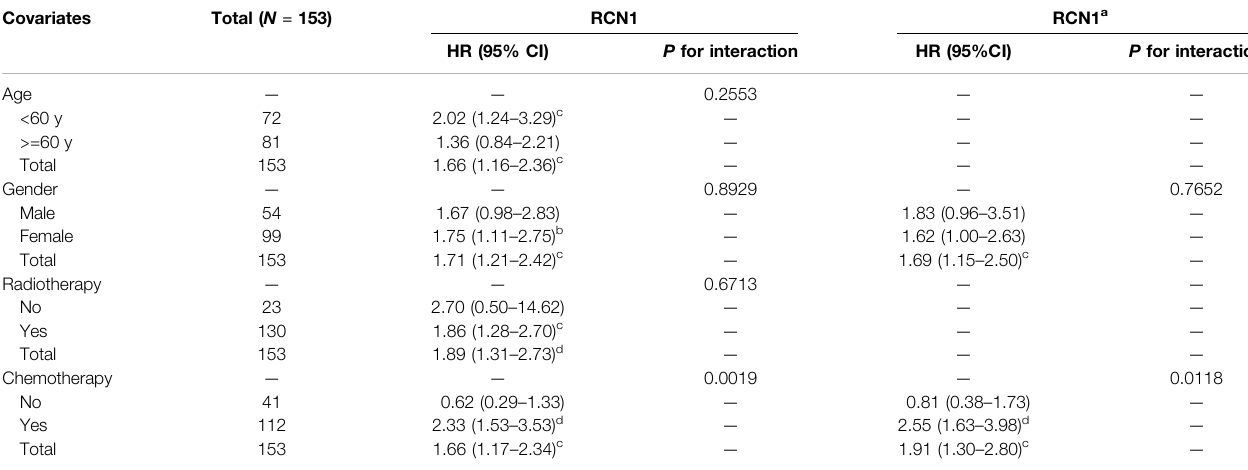
TABLE 3 | Subgroup analysis of the associations between OS and RCN1 of patients with GBM in TCGA. Covariates Total ( N = 153)